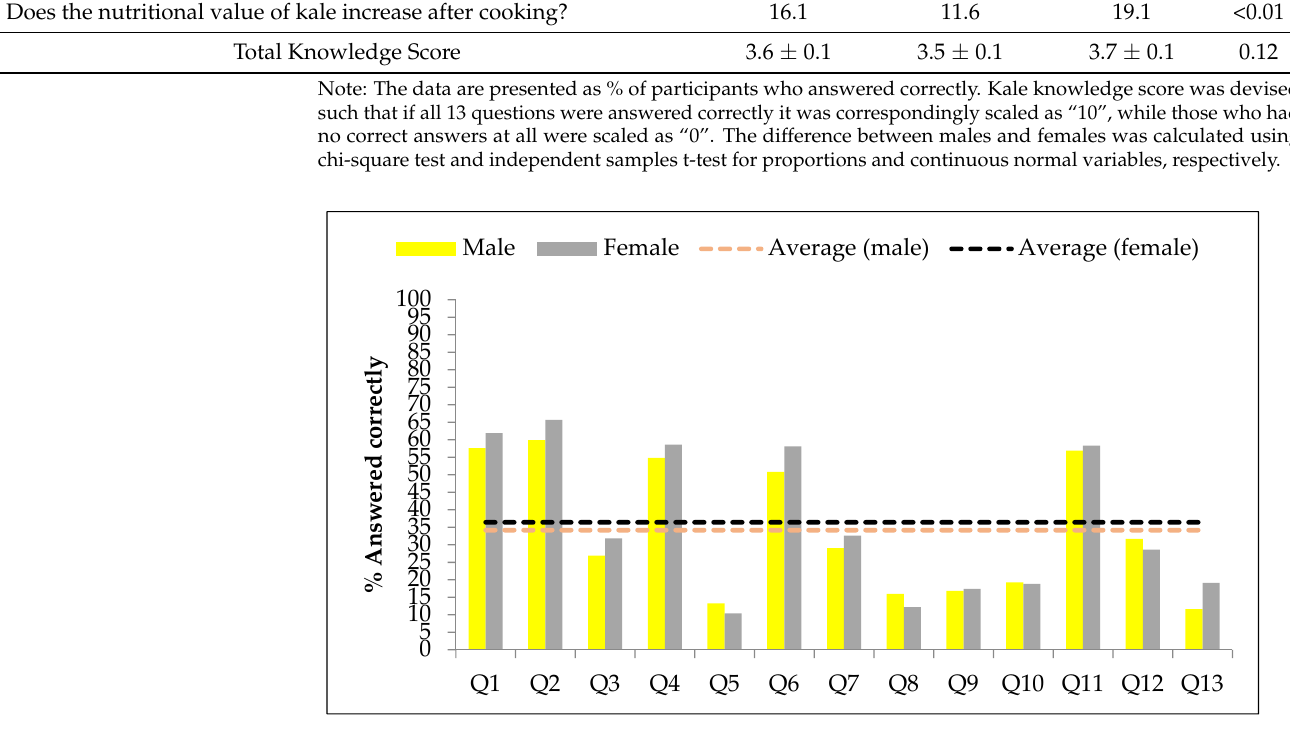
summarized in Table 3. The total knowledge score (scaled as 0–10) in the study participants was divided into tertiles, with tertile 1 and tertile 3 having the lowest and highest kale knowledge scores, respectively, and a regression analysis was run. For all the subjects and the females only, age, family income, and educational status were all significant contributors for predicting better knowledge scores, as the older participants with a higher income and higher educational qualification scored higher compared to the younger participants with a lower income and lower educational qualification. In males, a higher educational qualification was the sole significant contributor among the socio-demographic variables, with an odds ratio of 2.66 ( p < 0.05) in post-graduates compared to those who have only studied to secondary